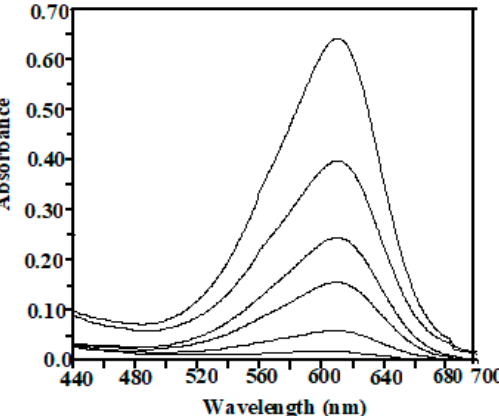
Figure 7. The time-resolved absorption spectra during the reaction of 100 ppm of IC in the presence of 100 mg Cu II /NA-PVA catalyst under UV illumination. Decreasing absorbance of the bands for IC is related to 0.0 to 60 min from up to down.